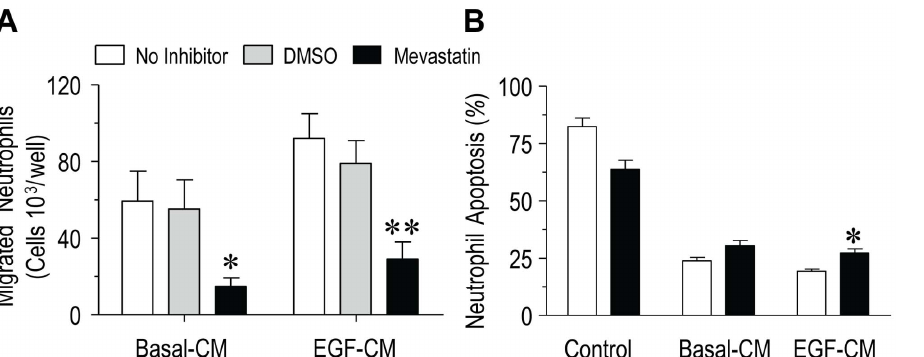
Figure 6. Regulation of RhoA GTPase during neutrophil chemotaxis and survival mediated by PBEC-CM from Mod/Sev asthmatics. (A) Pre-treatment of neutrophils with mevastatin (50 m M for 30 min; solid bars ) attenuated both basal-CM and EGF-CM-mediated chemoattraction compared with the non-drug treated controls (p=0.047 and p=0.012, respectively). Vehicle-treated control cells were treated with 0.1% v/v DMSO ( n =5 donors). (B) Mevastatin did not affect basal-CM mediated neutrophil anti-apoptosis but partially inhibited EGF-CM-induced survival (p=0.038) ( n =6 donors). Data represent mean 6 SEM and statistical significance by paired t -test *p , 0.05 vs. non-drug treated neutrophils.